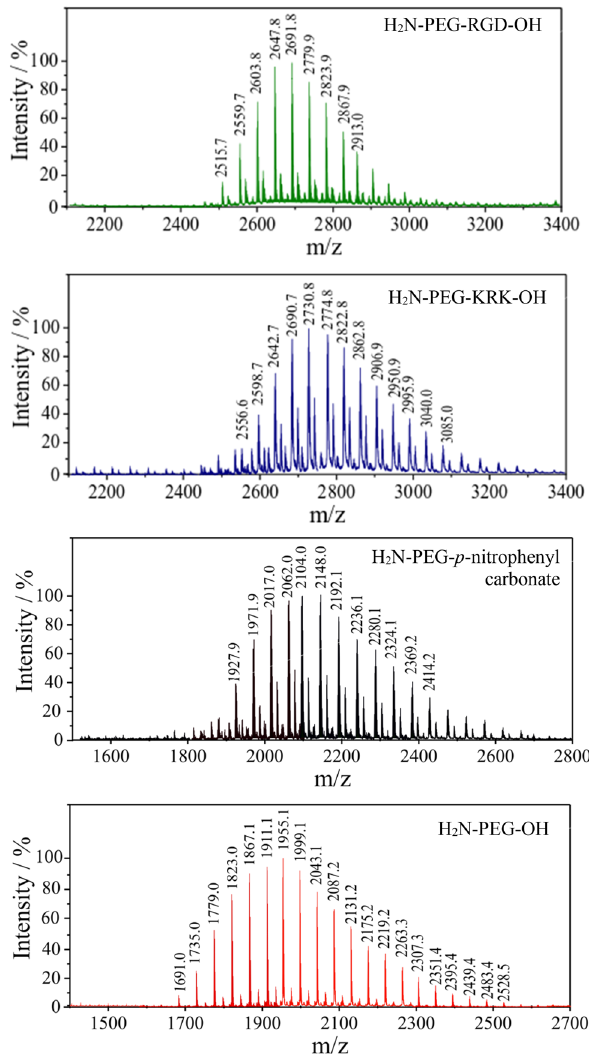
Figure 6. MALDI-TOF mass spectra of: native H 2 N-PEG-OH polymer, activated H 2 N-PEG- p -nitrophenyl carbonate,